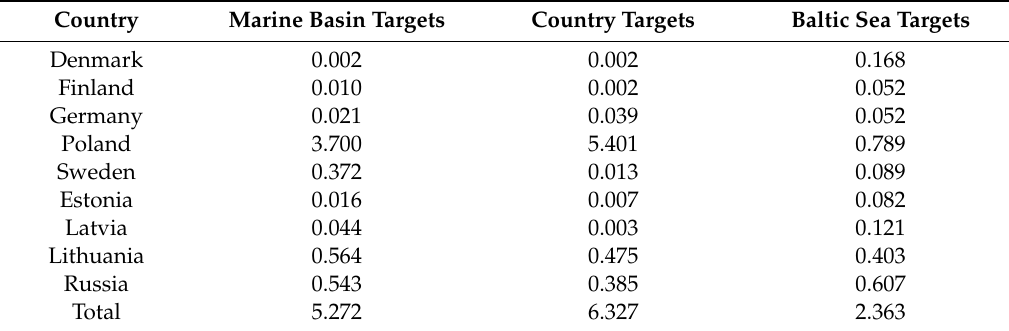
Table 2. Allocation of costs between countries under marine basin, country, and Baltic Sea targets. Country Marine Basin Targets